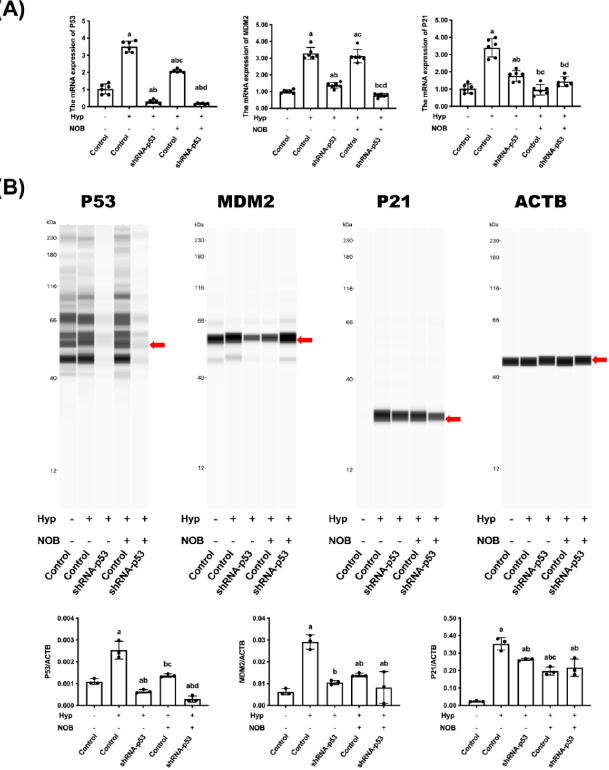
Figure 5. P53 signaling pathway played a critical role in alleviating the hypoxia-induced apoptosis of BeWo cells. ( A ) The mRNA expressions of P53, MDM2, and P21 were estimated by RT-qPCR. ACTB was used as an internal control. ( B ) The protein expressions of P53, MDM2, and P21 were detected using Wes. ACTB was used as an internal control, and the relative protein expression was the ratio of the target protein to ACTB. Data are expressed as the mean ± standard error (Mean ± SEM). a: comparing with the control groups, p < 0.05; b: comparing with the hypoxia groups, p < 0.05; c: comparing with the hypoxia+shRNA-P53 groups, p <0.05; d: comparing with the hypoxia + NOB groups, p <